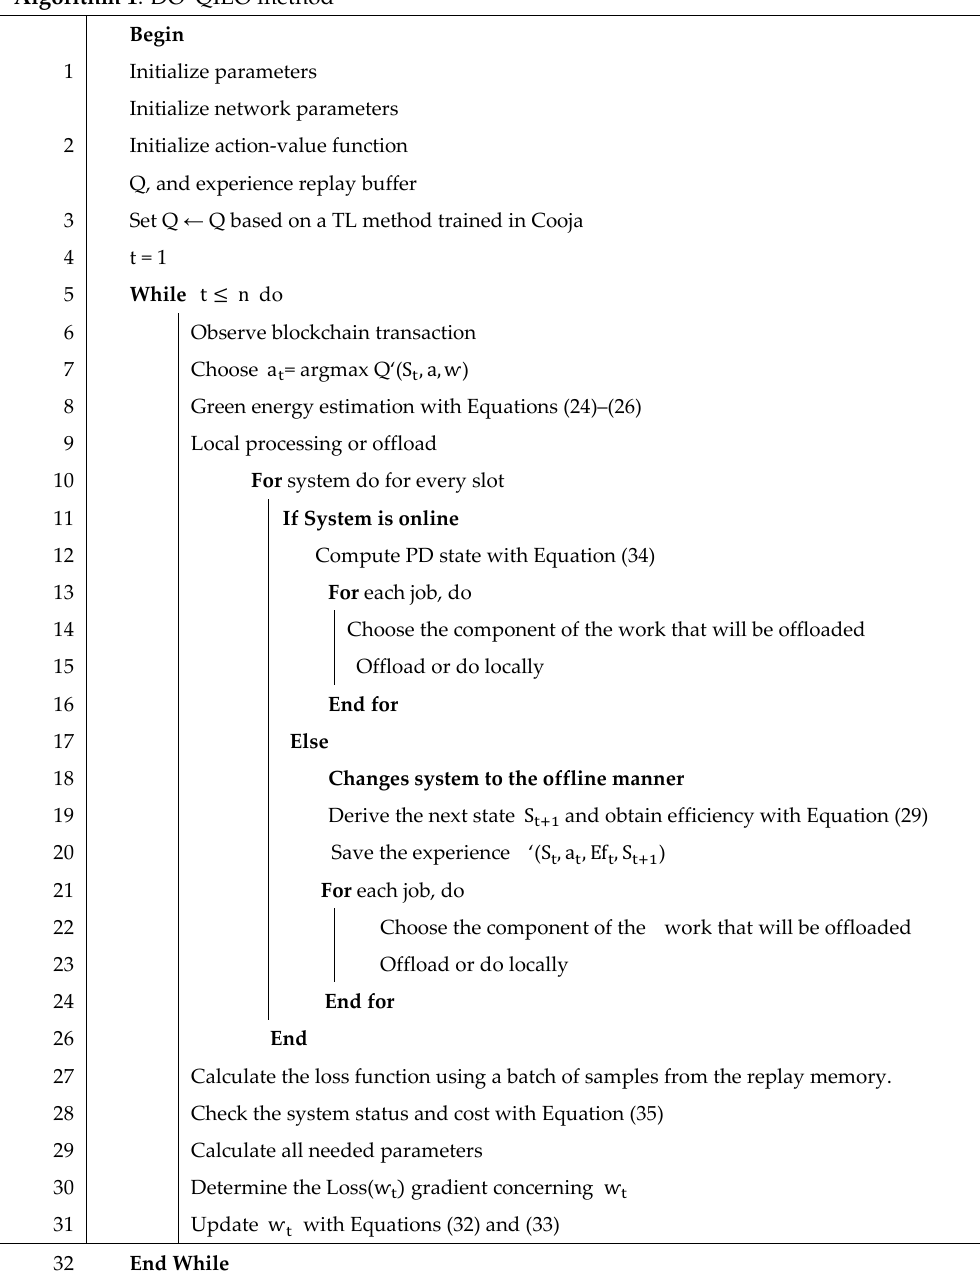
Algorithm 1 . DO 2 QIEO method Algorithm 1. DO 2 QIEO